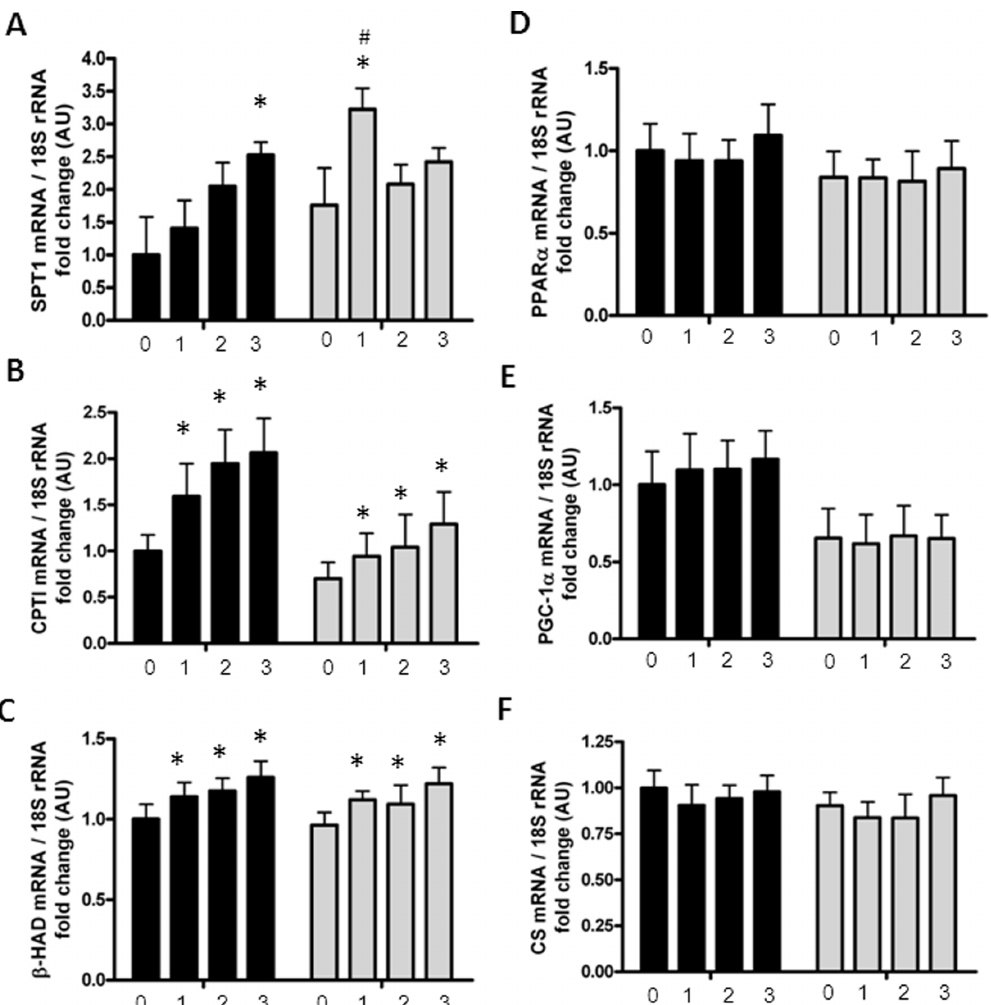
Figure 4. mRNA expression in palmitate treated myotubes from premenopausal and postmenopausal women. Satellite cells were isolated from vastus lateralis biopsies from premenopausal and postmenopausal women. Cells were grown in culture until mature myotubes were formed. Myotubes were treated with palmitate (300 m M) in the last one, two or three days of differentiation. The mRNA levels of analyzed genes and the endogenous control 18S were determined by quantitative real time PCR. mRNA expression in pre-myotubes (n=6, black bars) and post- myotubes (n=5, white bars) following zero-, one-, two- or three days of palmitate treatment (300 m M), (A) There was a menopause*palmitate interaction on SPT1, as one day of palmitate treatment led to a significant increase in SPT1 mRNA in post-myotubes. Furthermore, one day of palmitate treatment led to a significantly higher expression of SPT1 mRNA in post-myotubes compared to pre-myotubes. Three days of palmitate treatment increased SPT1 expression significantly in pre-myotubes, compared to the control, (B) CPTI mRNA expression increased significantly in response to palmitate treatment in myotubes from both groups, (C) b -HAD mRNA expression increased significantly in response to palmitate treatment in myotubes from both groups, (D) PPAR a mRNA expression was unaffected by both palmitate treatment and menopausal status, (E) PGC- 1 a mRNA expression was unaffected by both palmitate treatment and menopausal status, (F) CS mRNA expression was unaffected by both palmitate treatment and menopausal status, 18S was used as the house keeping gene and did not differ between groups. 0: Zero days of palmitate treatment (control), 1: One day of palmitate treatment, 2: Two days of palmitate treatment, 3: Three days of palmitate treatment. Significantly different from control; * p , 0.05. Significantly different from premenopausal, at same palmitate exposure time; # p , 0.05. All data were normalized to the premenopausal control group. Data are presented as means 6 SEM.